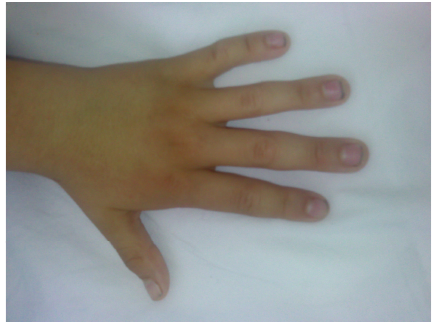
Figure 1: The presence of arachnodactyly.